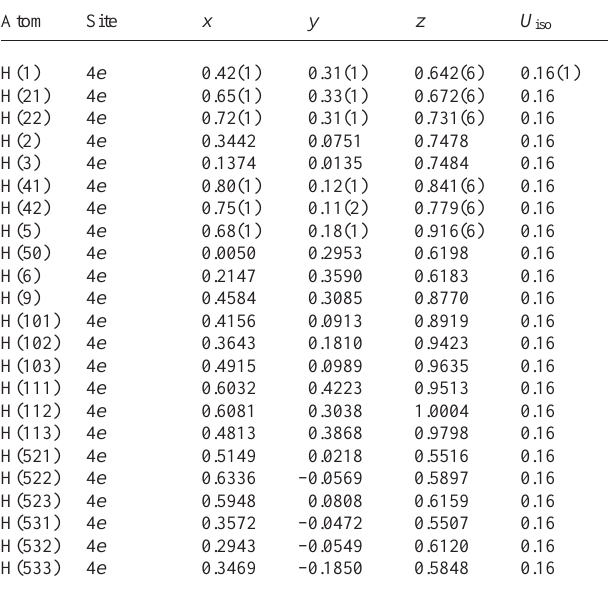
Table 5. Atomic coordinates and displacement parameters (in Å 2 )